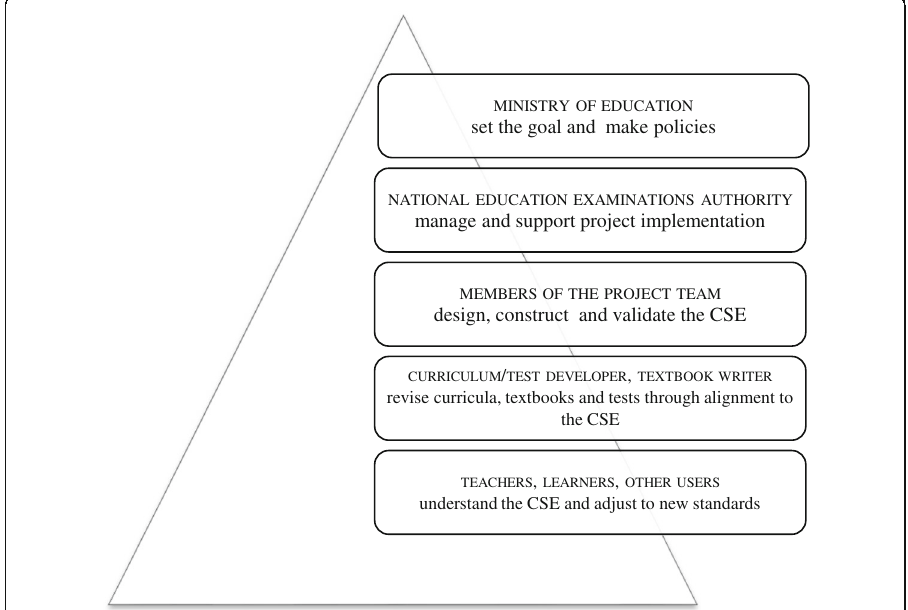
Fig. 1 Major groups of stakeholders and their roles in the